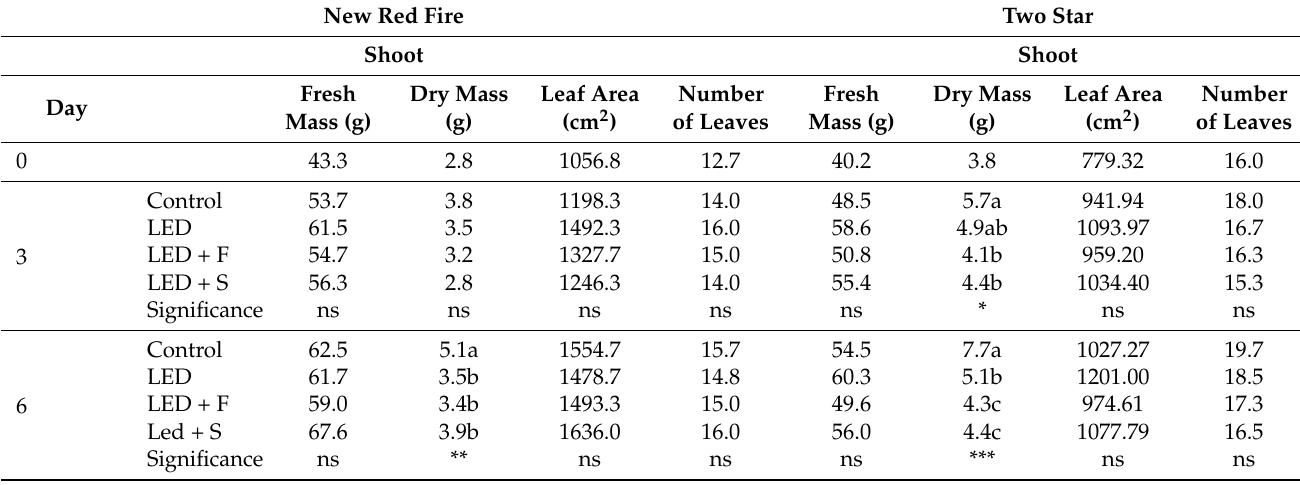
Table 2. Shoot fresh mass, dry mass, leaf area, and leaf number of lettuce varieties, ‘New Red Fire’ and ‘Two Star’, subjected to supplemental UV-A radiation for 3 or 6 days before harvest. Treatments included LEDs, LEDs + focus lens (LED + F), LEDs + scatter lens (LED + S), and control (Con). Measurements were made at 0, 3, and 6 days of